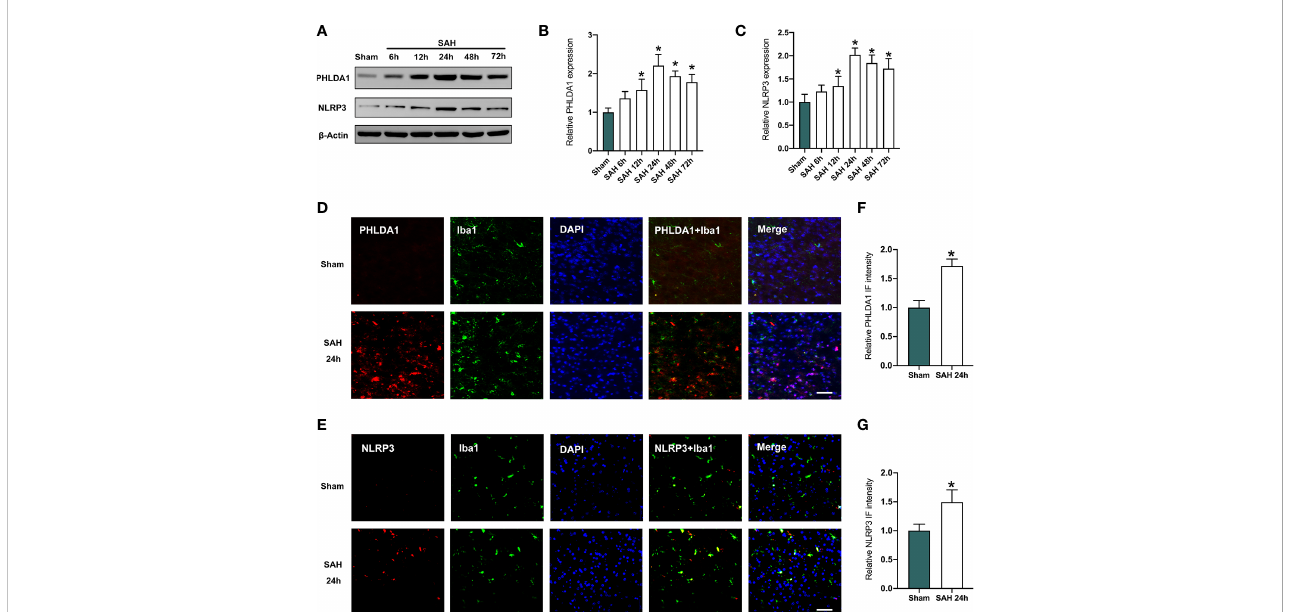
FIGURE 1 Expression levels of PHLDA1 and NLRP3 were increased after SAH. (A) Representative western blots for PHLDA1 and NLRP3 expressions in the early period after SAH. Western blot analysis of PHLDA1 (B) and NLRP3 (C) expressions after SAH (n = 6 per group). (D, E) Representative immuno fl uorescence images of PHLDA1 and NLRP3 co-localized with Iba1 in temporal cortex after SAH. Quanti fi cation of PHLDA1 (F) and NLRP3 (G) immunoactivities in microglia (n = 6 per group). * P < 0.05. Scale bar=50 m m. Data are expressed as mean ±